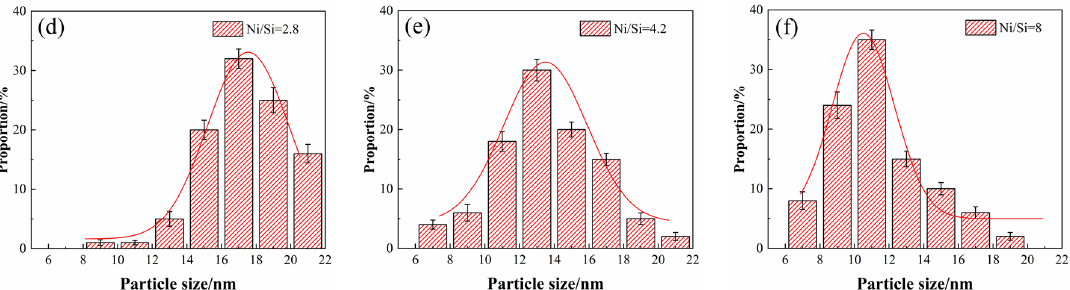
Figure 7. Transmission electron microscopy (TEM) images of alloy microstructure and particle size of alloys with different Ni/Si mass ratios aged at 500 °C for 2 h; ( a , d ) NS ‐ 1, ( b , e ) NS ‐ 4, and ( c , f ) NS ‐ 9.